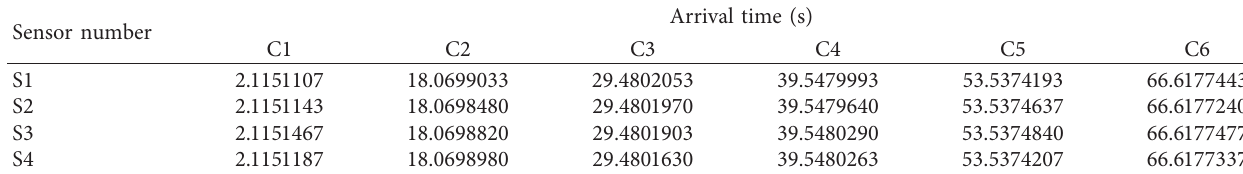
Table 12: First arrival time of the pulse sources for Scheme II of